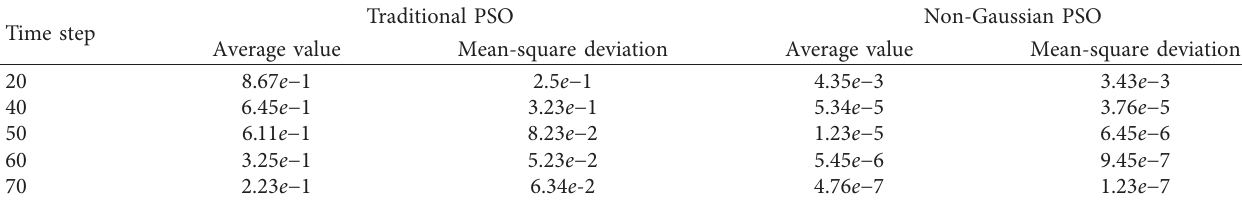
Table 3: Statistical analysis of errors by different methods.